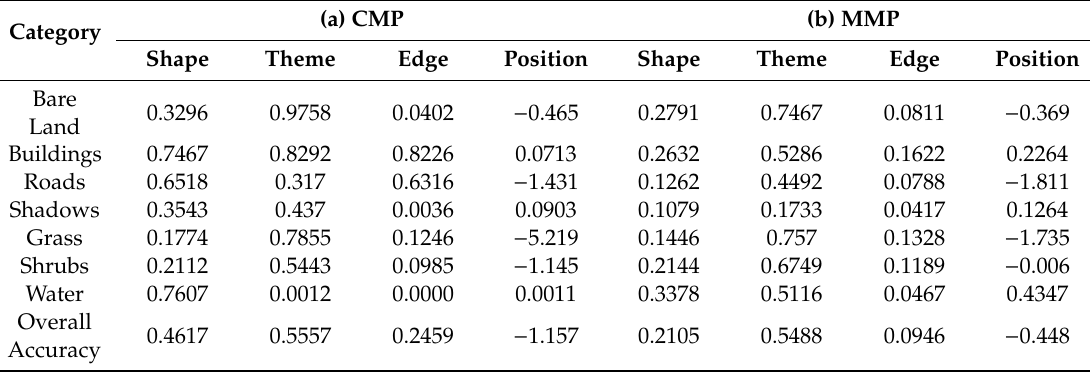
Table 5. Overall thematic and geometric accuracy results of (a) CMP and (b) MMP over Sunninghill. Category